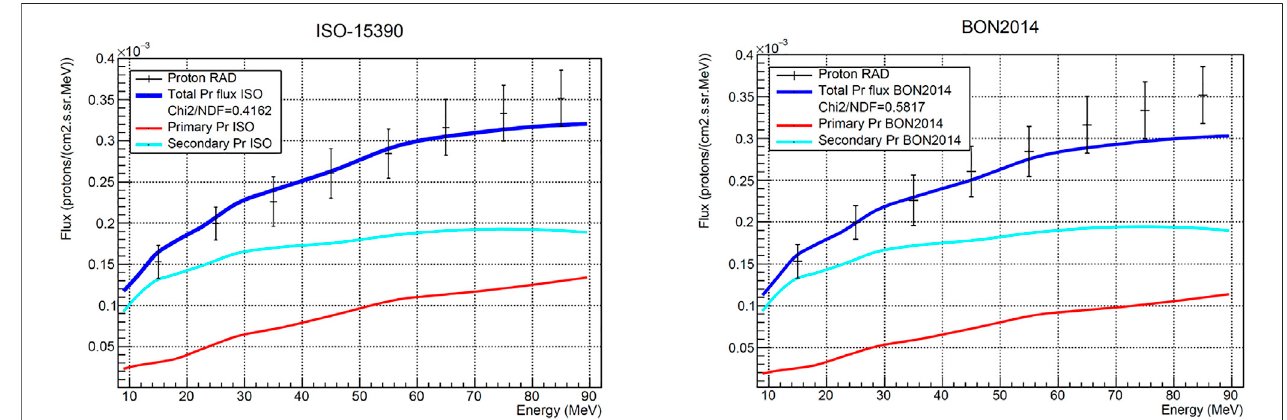
FIGURE6| Differential proton fl ux spectraobtained withdMEREM compared toGCR-induced proton spectrum measuredby RADin September 2017,extracted from (Ehresmann et al., 2018). Protons from primary (red) and secondary (cyan) origin are shown. dMEREM prediction based on ISO-15390 model (left) and on BON2014 model (right) are shown.